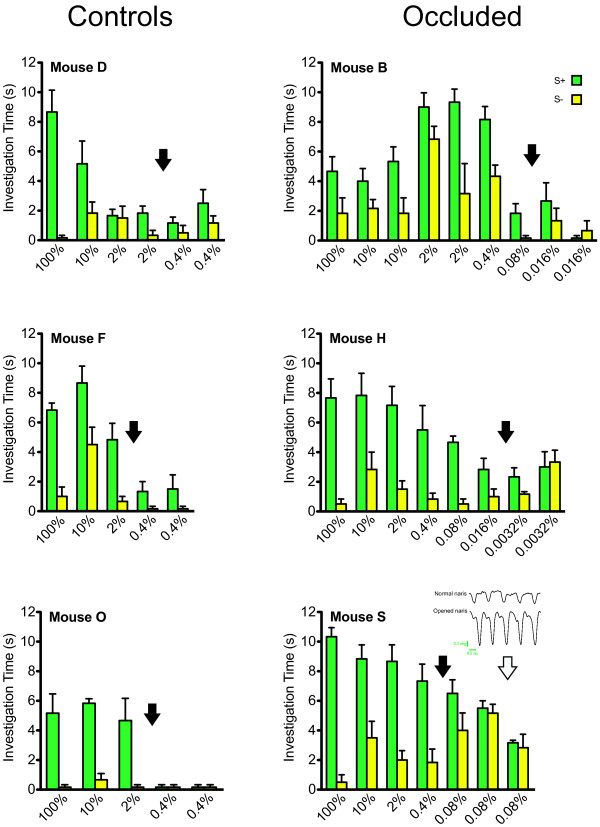
Discrimination Results. Mean (± SEM) digging times for unilaterally bulb-x mice during 60 sec discrimination trials comparing two sand-filled dishes containing either S+ or S- odors. Data in the left column (controls) are from three of four trained adult mice that had normal nares. Data in the right column (occluded) are from three of four trained adult mice that had a naris occluded on the first postnatal day positioned contralateral to their subsequent adult bulb-x. Mice were tested on their ability to discriminate the S- and increasingly diluted S+ in S- stock (see methods). Filled arrows designate threshold as determined by lowest dilution (just left of arrow) at which the mouse showed significant discrimination by Mann-Whitney test (p < 0.05) in a six trial block. Note that a mouse had to fail to discriminate a given dilution on two consecutive days to establish threshold. In the case of Mouse S (lower right panel), after threshold was determined its formerly occluded naris was opened surgically (open arrow). The traces in the inset are recordings from a thermistor probe placed just inside the external nares after naris opening. These traces establish that respiration was restored through the surgically reopened naris. After a two-day recovery period following naris reopening, Mouse S again failed to discriminate the dilution (0.08% S+ stock in S- stock) it had previously failed on during threshold testing.